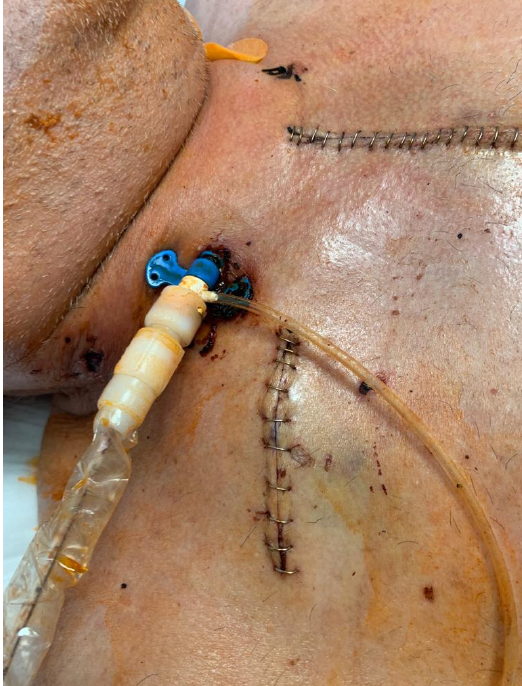
Figure 4. Final result with repositioning sheath secured to the skin. The graft is trimmed to sit below skin level.